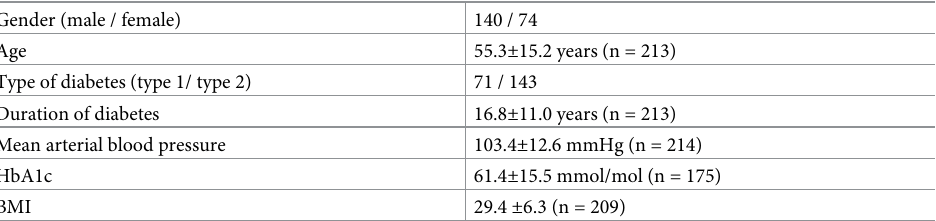
Table 1. Group characteristics at baseline (mean ± standard